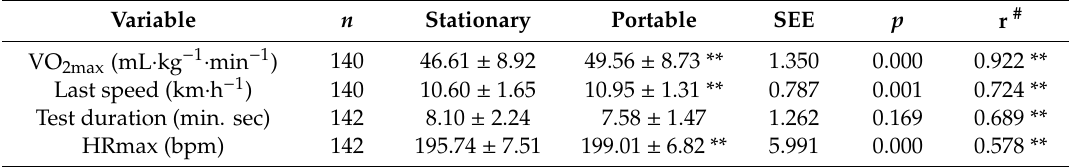
Table 3. Comparison of measured VO 2max between stationary and potable gas analyzers.